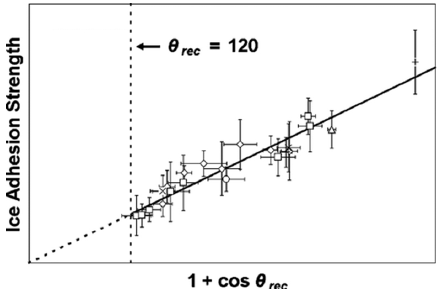
Figure 7. Ice adhesion strength as a function of practical work of adhesion. Reprinted with permission from Ref. [25]. c (cid:13) 2010 American Chemical